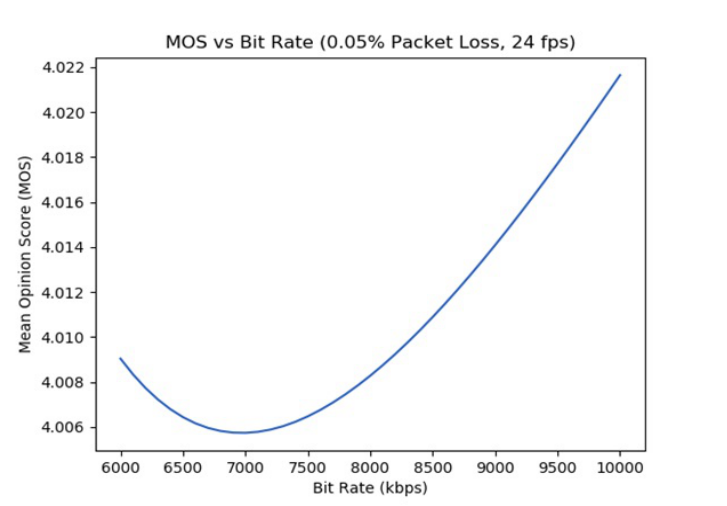
Figure 6. MOS with respect to bit rate (ITU-T Recommendation